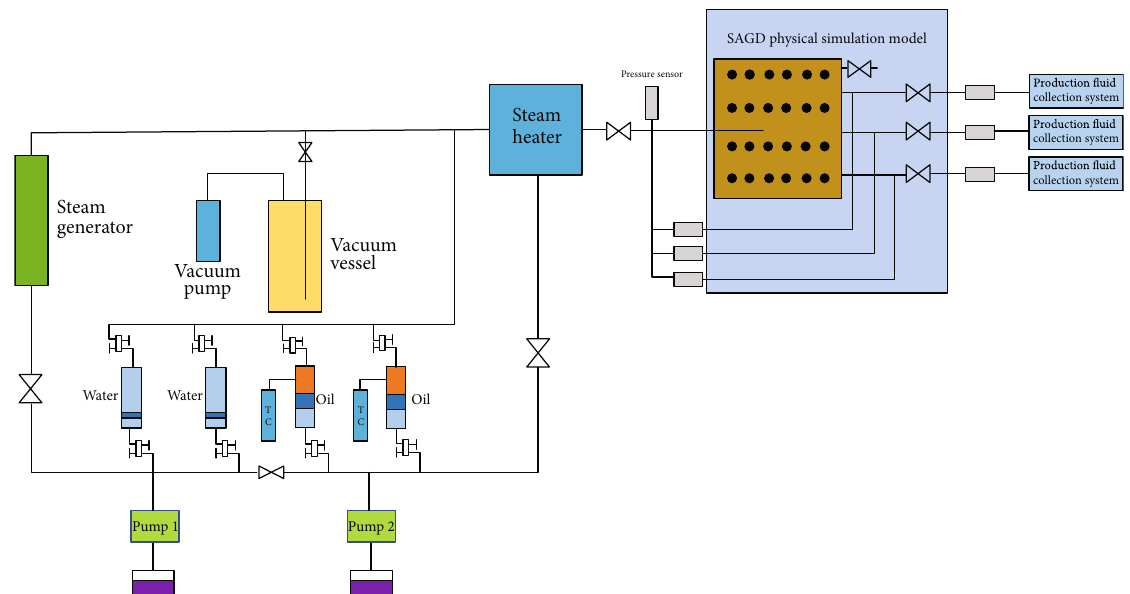
Figure 1: Schematic diagram of the SAGD 2-D physical simulation experiment